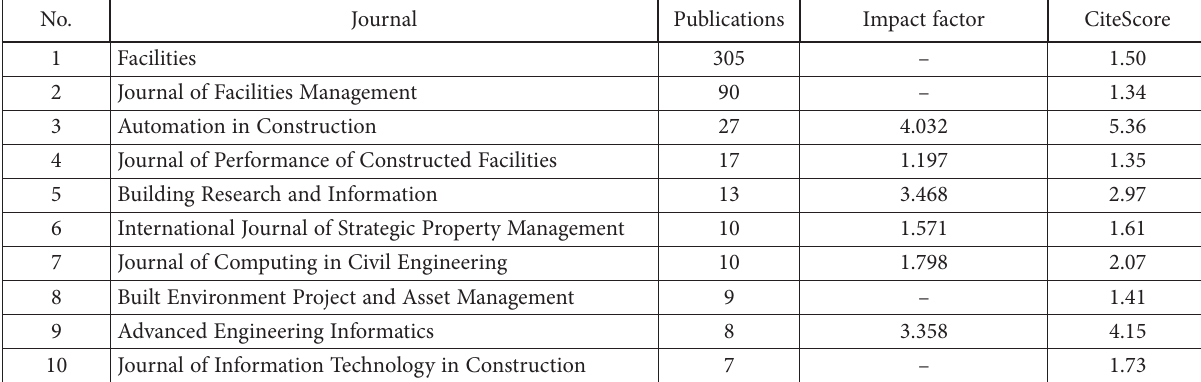
Table 1. Top-10 journals with impact factor and CiteScore